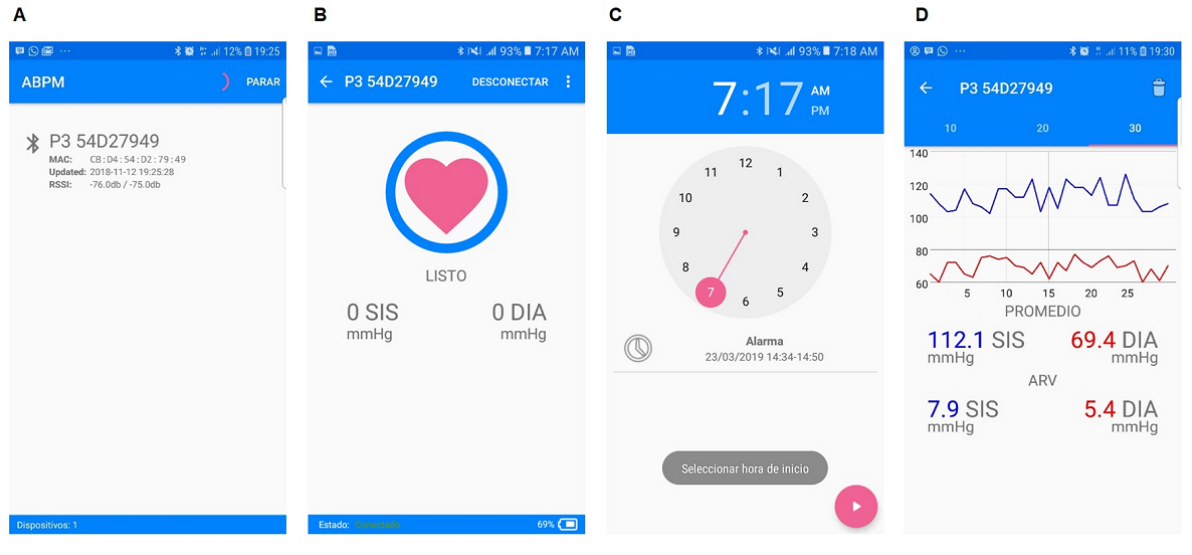
Figure 6. Screenshots of the mobile app operations for (A) Bluetooth pairing between the smartphone and photoplethysmography (PPG) sensor, (B) established connection showing the battery power indicator of the PPG sensor, (C) setting of the start time for blood pressure (BP) monitoring, and (D) deployment of continuous BP measures, average BP level, and BP variability